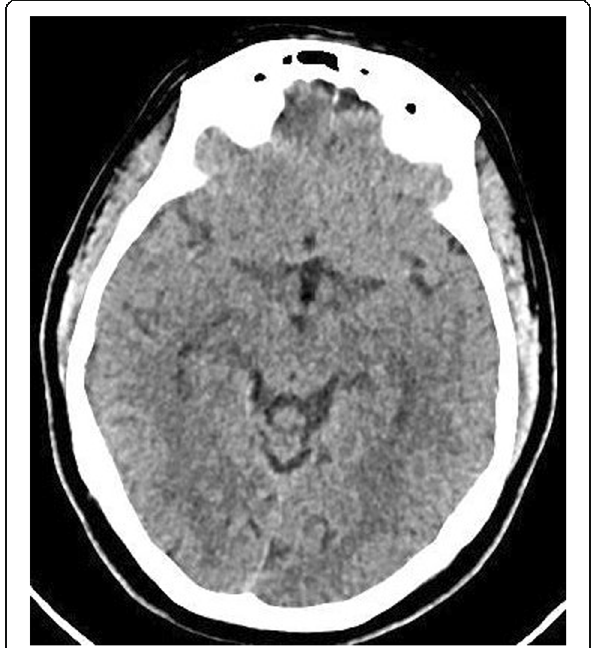
Fig. 4 Brain Scan, 03/15/2020, no signs for brain